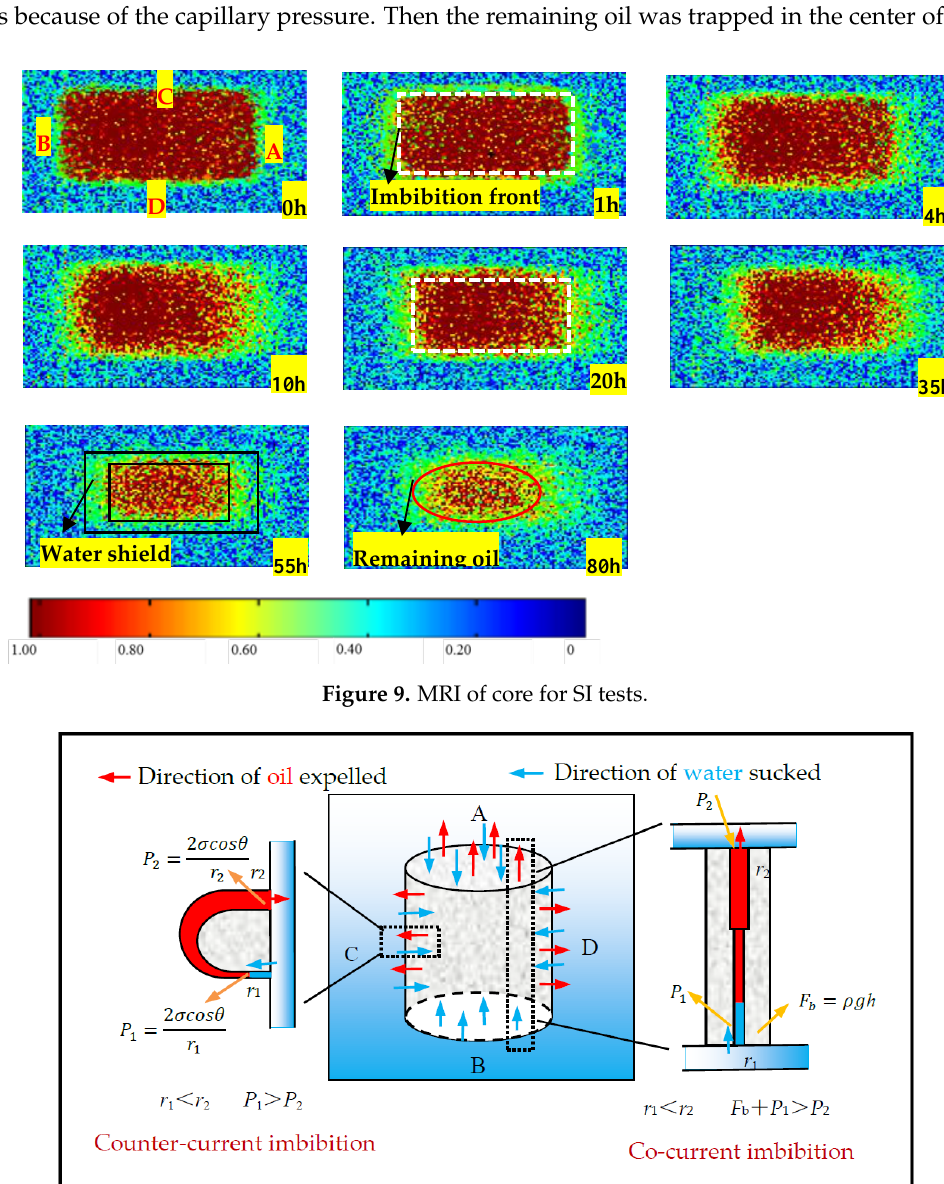
Figure 10. Counter-current imbibition and co-current imbibition mechanism map.